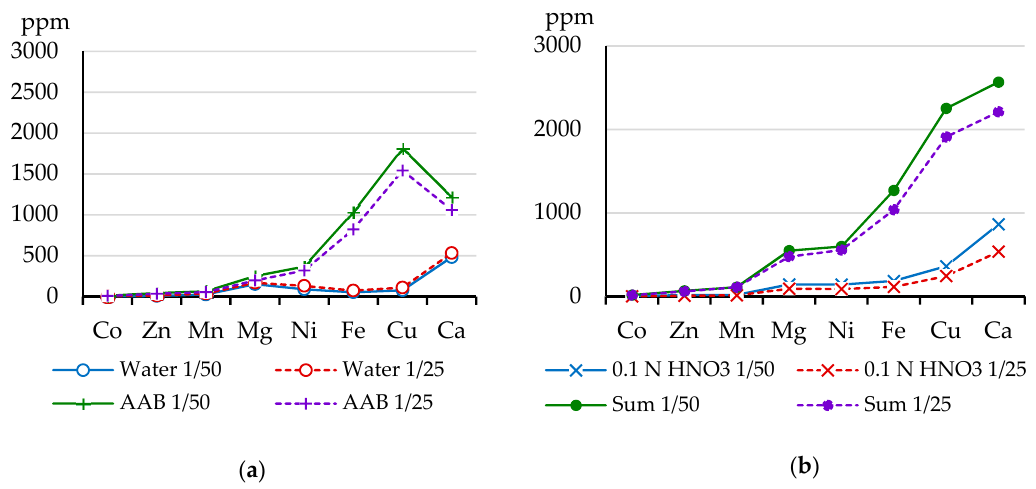
Figure 2. The content of element fractions after sequential treatment with solutions: ( a ) water and AAB; ( b ) 0.1N HNO 3 and the sum of fractions at the ratio of peat to solutions 1 g/50 mL (solid line) and 1 g/25 mL (dash line).